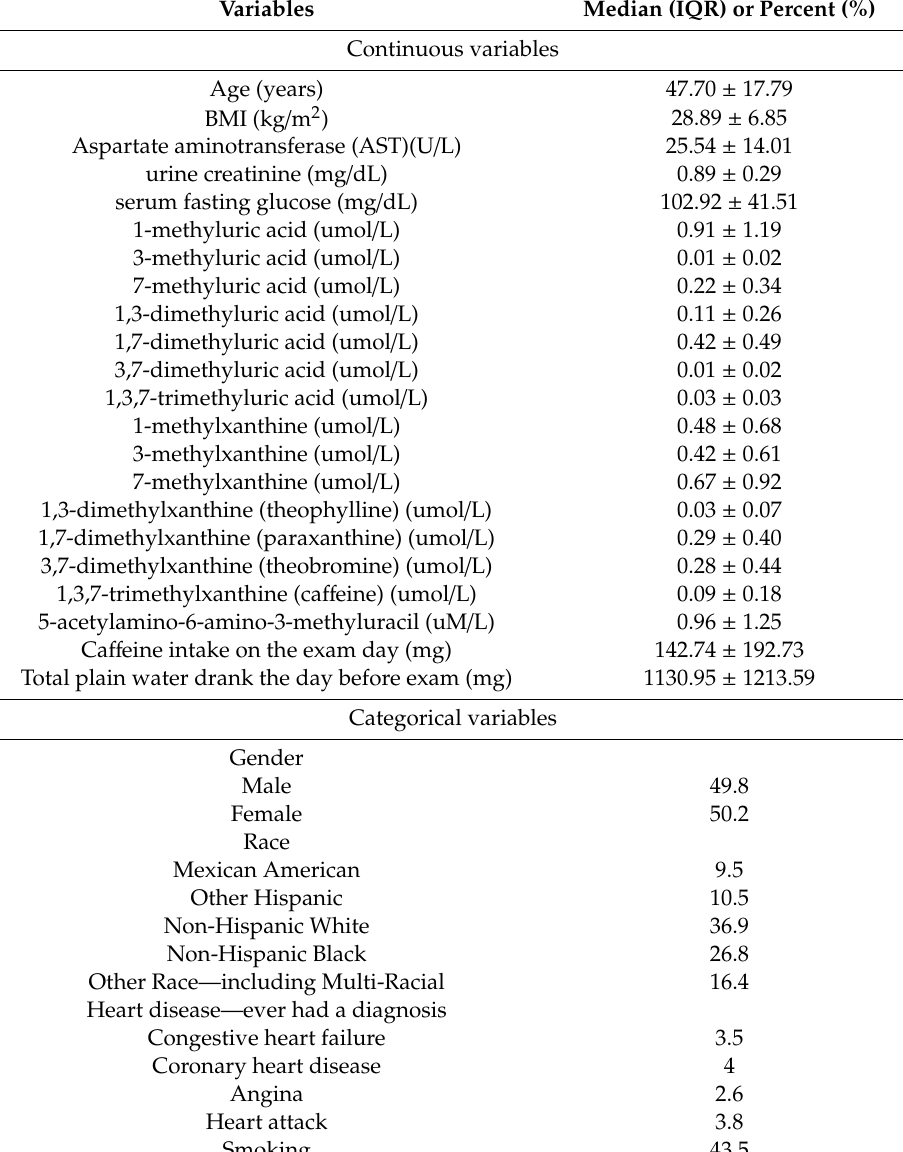
Table 1. Characteristics of